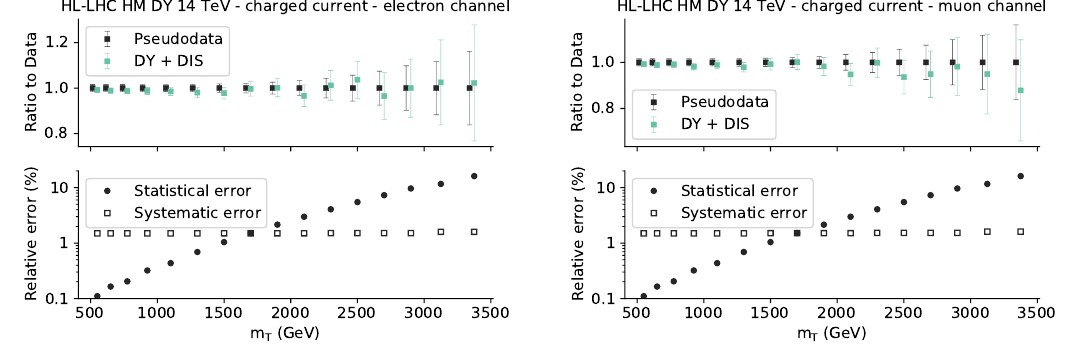
δ sys , where f is the expected reduction in sys- red ,j red ,j i,j